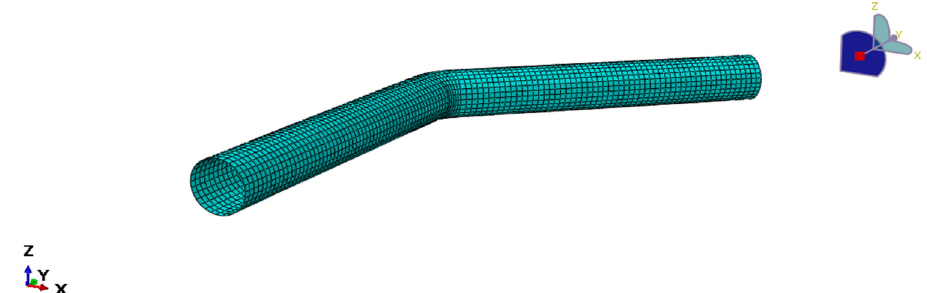
Figure 2: Pipe mesh.